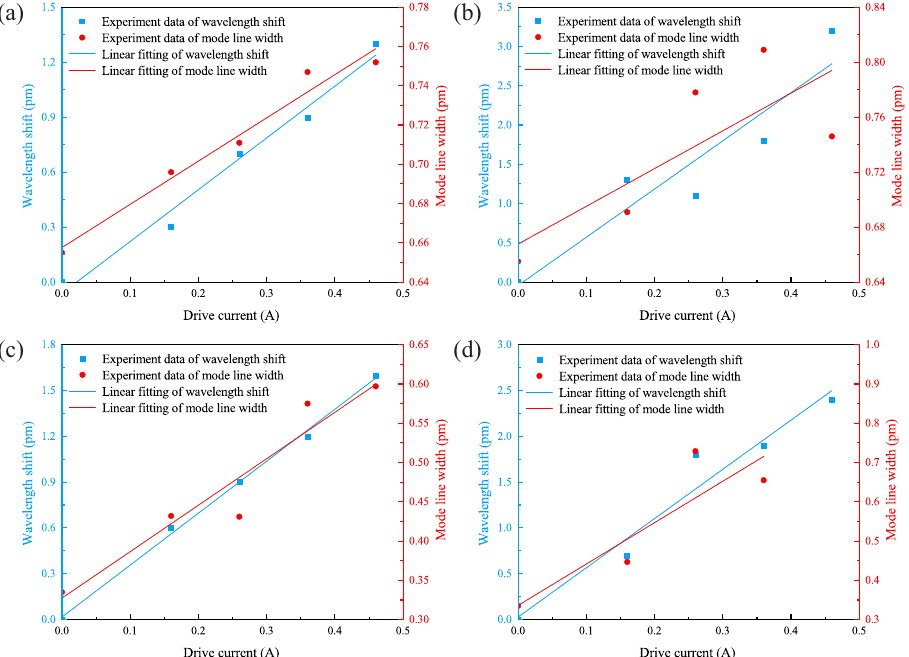
Figure 6. Experimental data and fitted curves of resonance wavelength shift and mode linewidth. ( a ) Mode i under the 26.9 kHz ultrasound. ( b ) Mode i under the 39.4 kHz ultrasound. ( c ) Mode ii under the 26.9 kHz ultrasound. ( d ) Mode ii under the 39.4 kHz